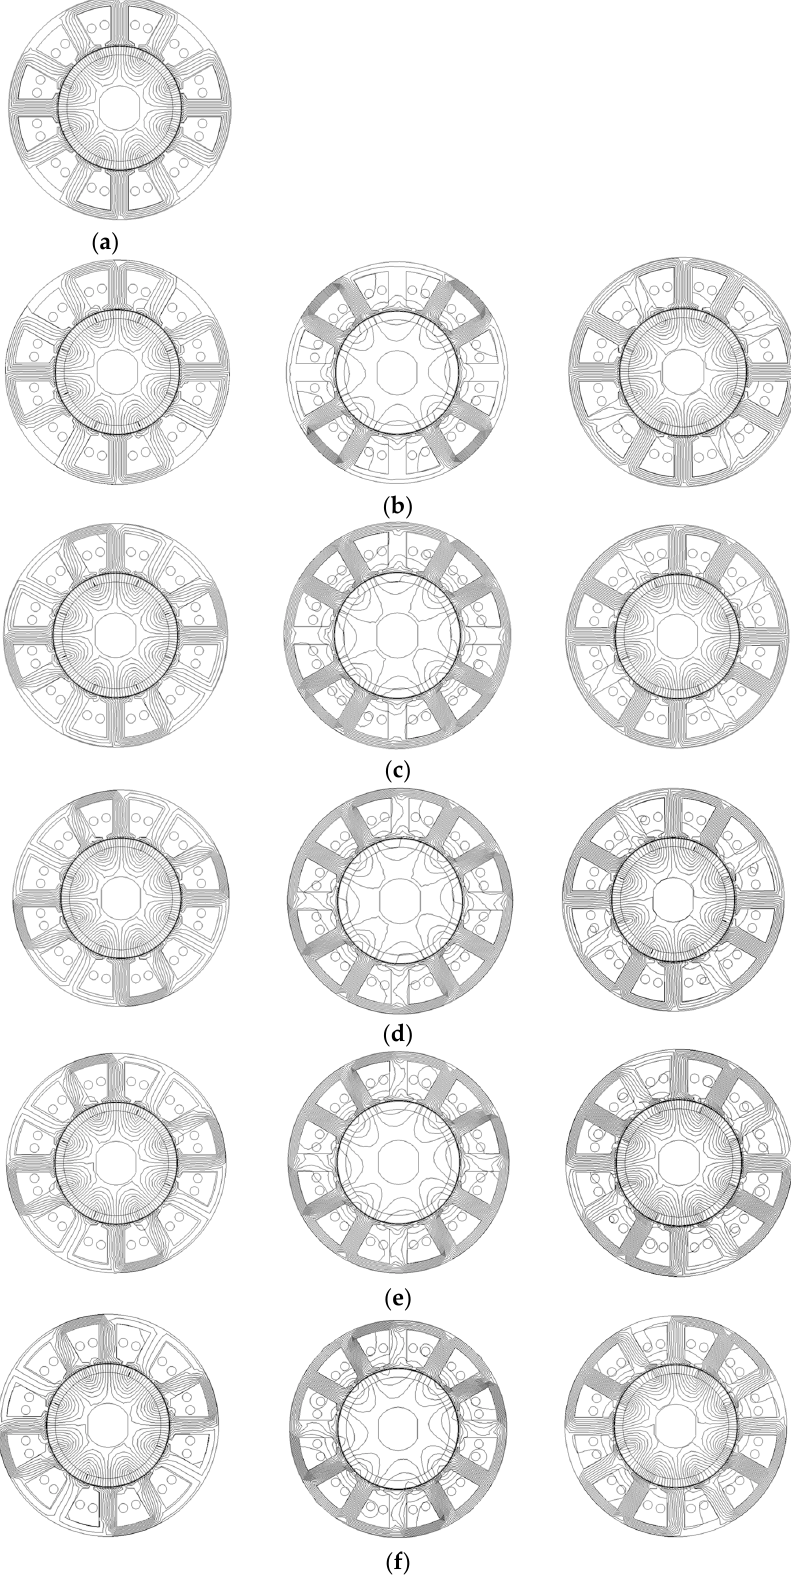
Figure 6. Equal potential distributions for 12s8p-SPM. (from left to right: PM only, armature current only, overall) ( a ) 0A. ( b ) 10A ( c ) 20A. ( d ) 30A. ( e ) 40A. ( f ) 50A.